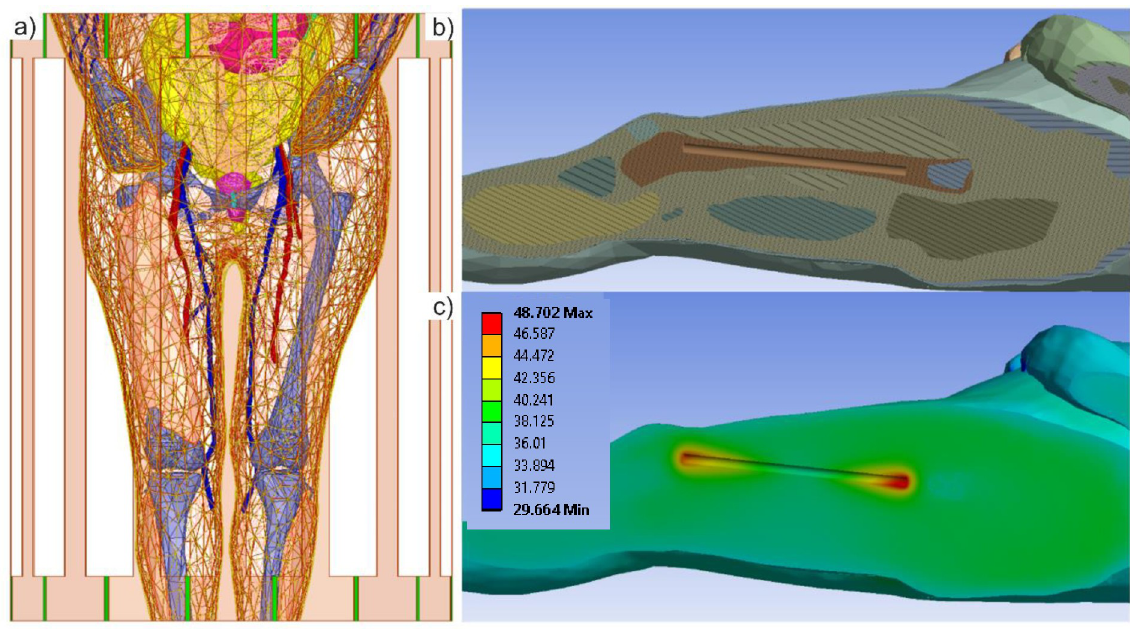
Fig 4. The VHP-Female computational phantom positioned with a 1.5 T MRI birdcage coil. Some body parts are removed for clarity. a)– The femur position is illustrated to show its orientation within the model–the metallic nail implant is aligned to reside within the trabecular bone structure. b)–Each individual object within Ansys Mechanical model is assigned specific thermal properties. c)–The temperature rise is shown after 900 seconds of continuous coil operation. These values correspond well with published experimental data [43–45]–see Table